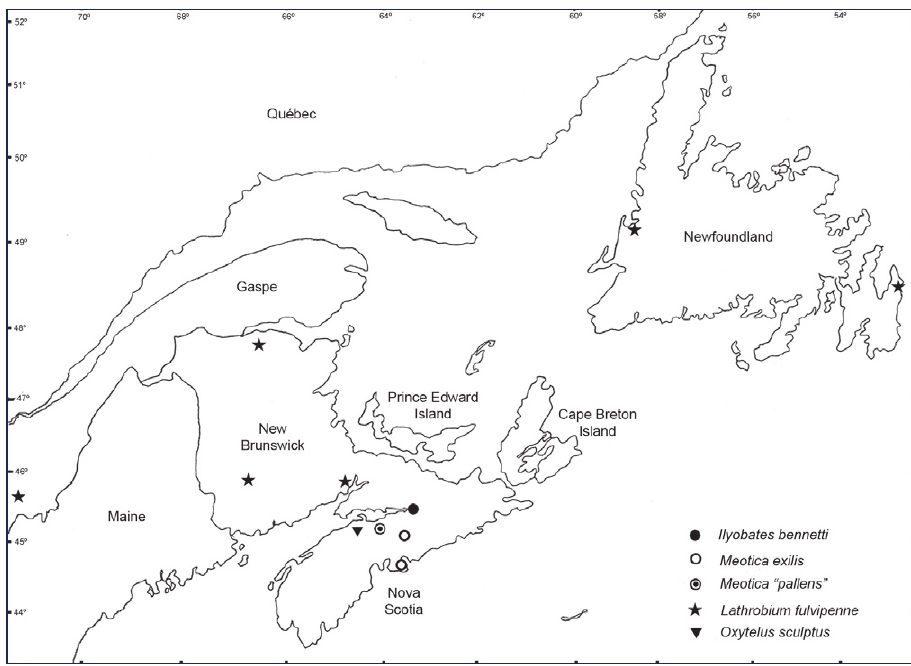
Fig. 1. Distribution of Ilyobates bennetti, Meotica exilis, Meotica “pallens,” Lathrobium fulvipenne, and Oxytelus sculptus in eastern